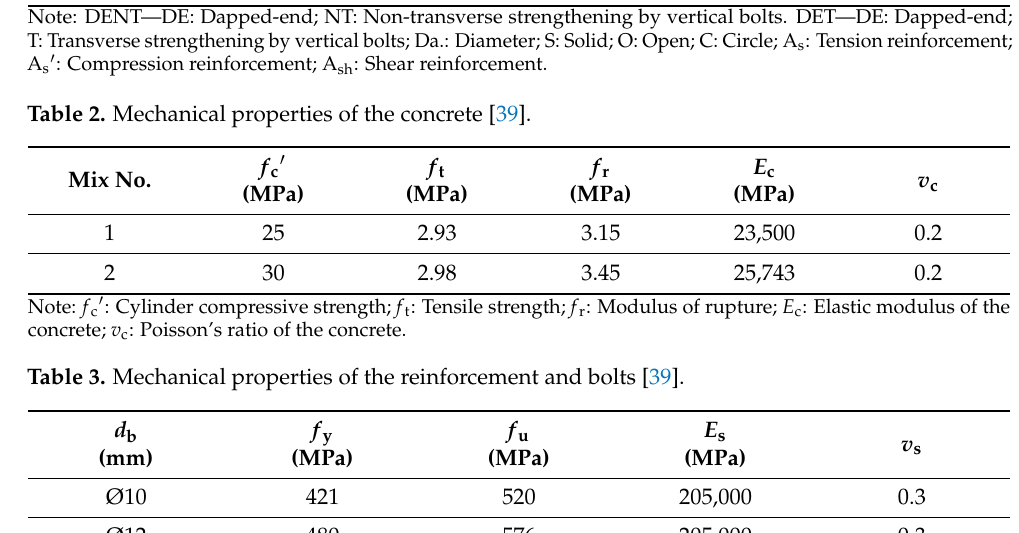
Table 3. Mechanical properties of the reinforcement and bolts [39].